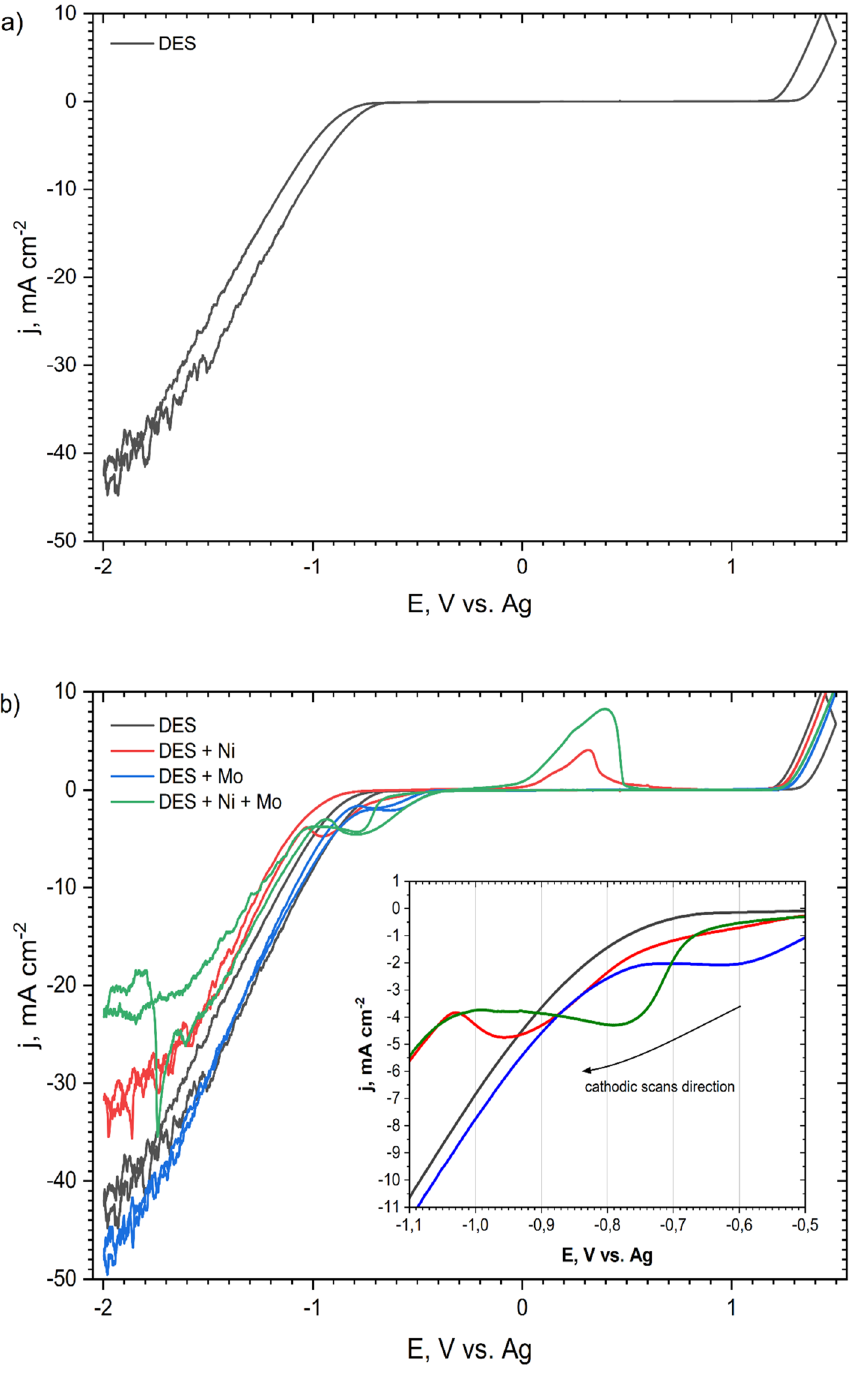
Figure 1. CV curves recorded on the Pt rotating disk electrode at 50 °C with a scan rate of 20 mV s –1 and a rotational speed of 700 rpm in: blank ChCl:PG 1:2 (denoted as ‘DES’) ( a , b ); ChCl:PG 1:2 + 0.2 mol dm −3 NiCl 2 (denoted as ‘DES + Ni’) ( b ); ChCl:PG 1:2 + 0.01 mol dm −3 (NH 4 ) 6 Mo 7 O 24 (denoted as ‘DES + Mo’) ( b ) and ChCl:PG 1:2 + 0.2 mol dm −3